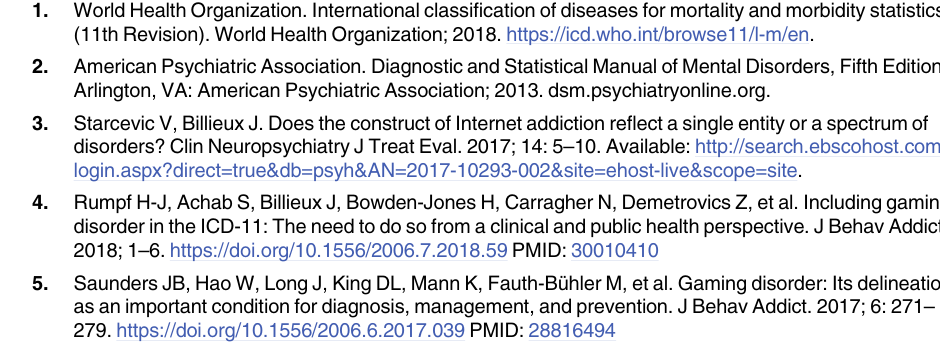
S1 Protocol. PROSPERO registration for our systematic review